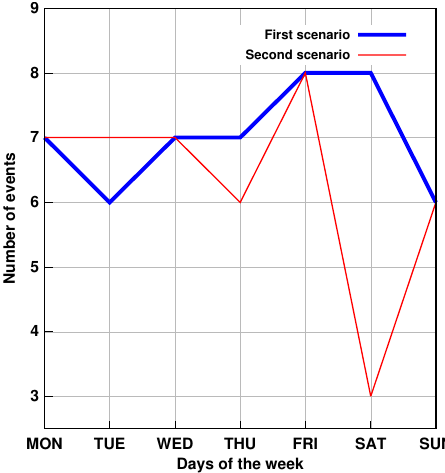
Figure 11. AGGIR Transfer events.